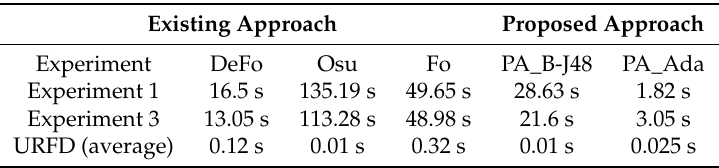
Table 4. Comparison of execution times (seconds) of the existing approaches under consideration and the proposed approaches on the MCF dataset (Experiments 1 & 3) and on the URFD dataset. The execution time was measured on the same machine under similar operating